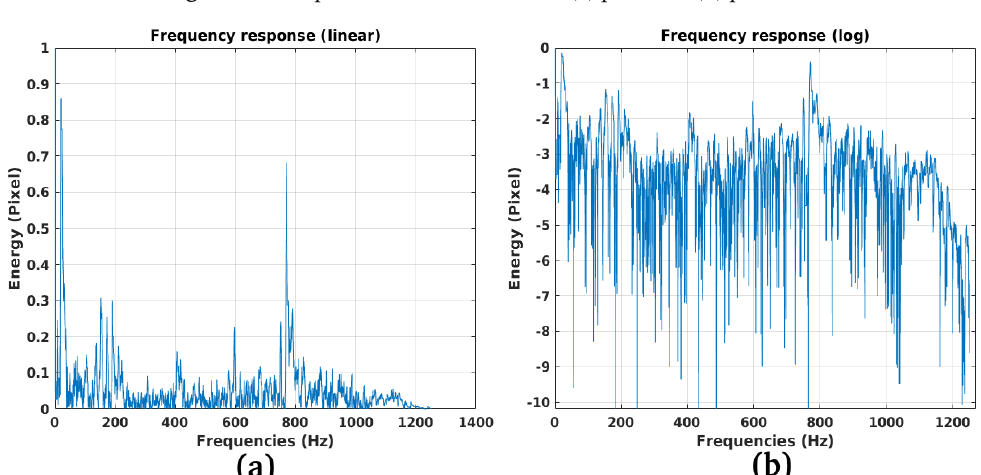
Figure 30. Vibration spectrum trend of P1 (DFT of Figure 29a): ( a ) Linear trend, ( b ) Logarithmic trend.